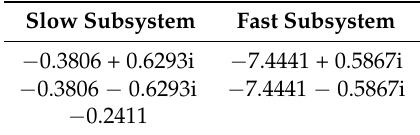
Table 2. Eigenvalues of the slow and fast decomposed